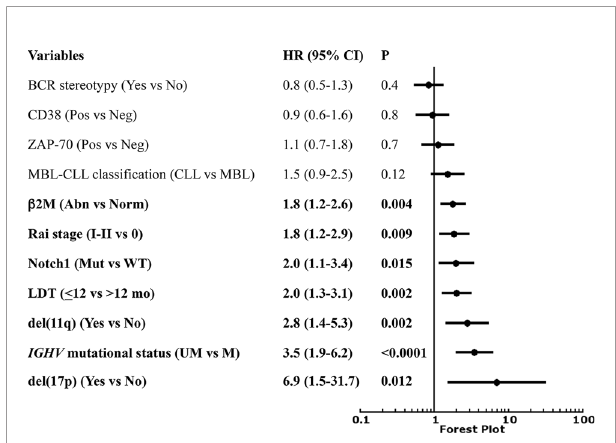
FIGURE 2 | Forest plot of Cox multivariate analysis for time to fi rst treatment (TTFT) according to several variables.